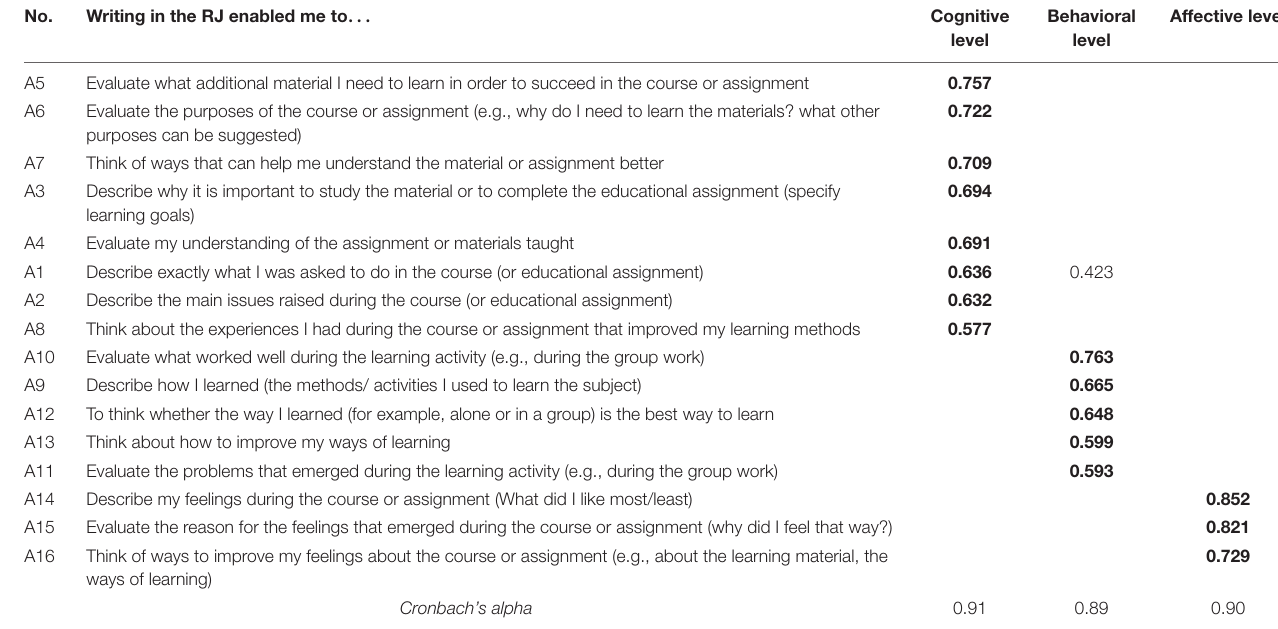
TABLE 2 | The short-term scale: factors, item descriptions, item loadings, and reliability results (Cronbach’s alpha) N = 141.